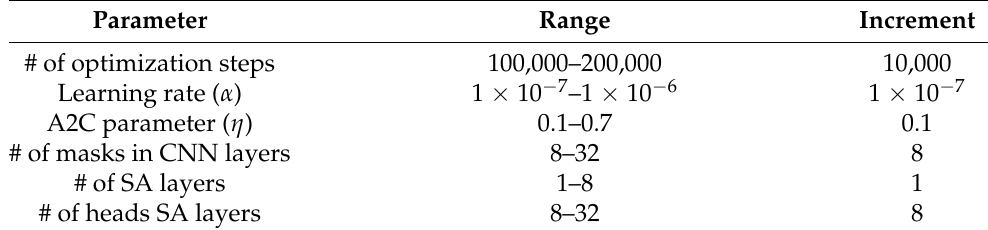
Table A1. Fine tuning